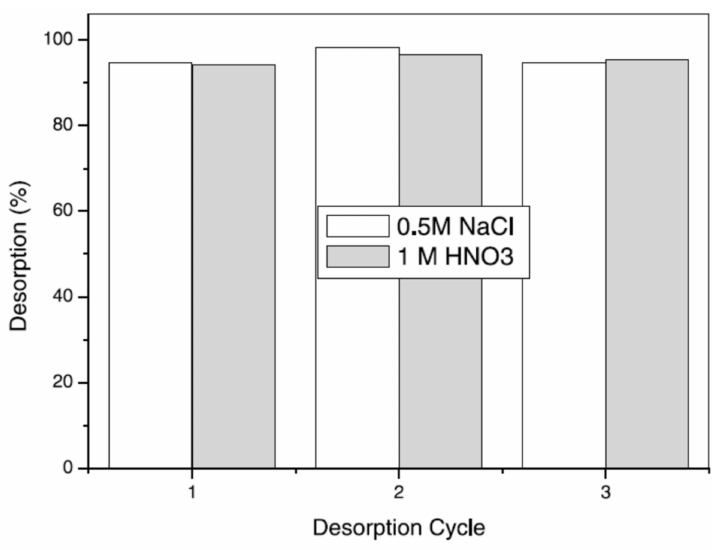
Figure 9. Desorption cycles of the poly (EGDMA-co-AAm) beads for Pb (II) metal ion. Reused with permission from